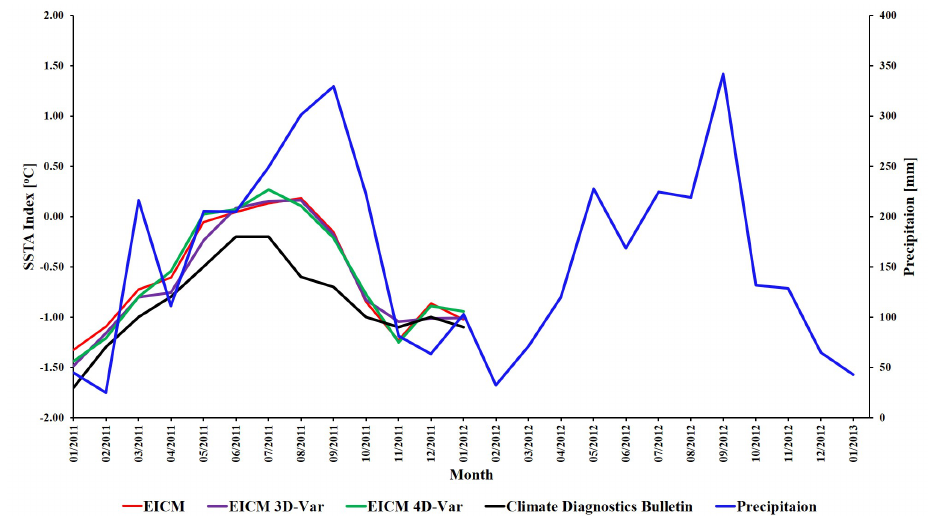
Figure 12. Relationship between SSTA index ( ◦ C) and Precipitation